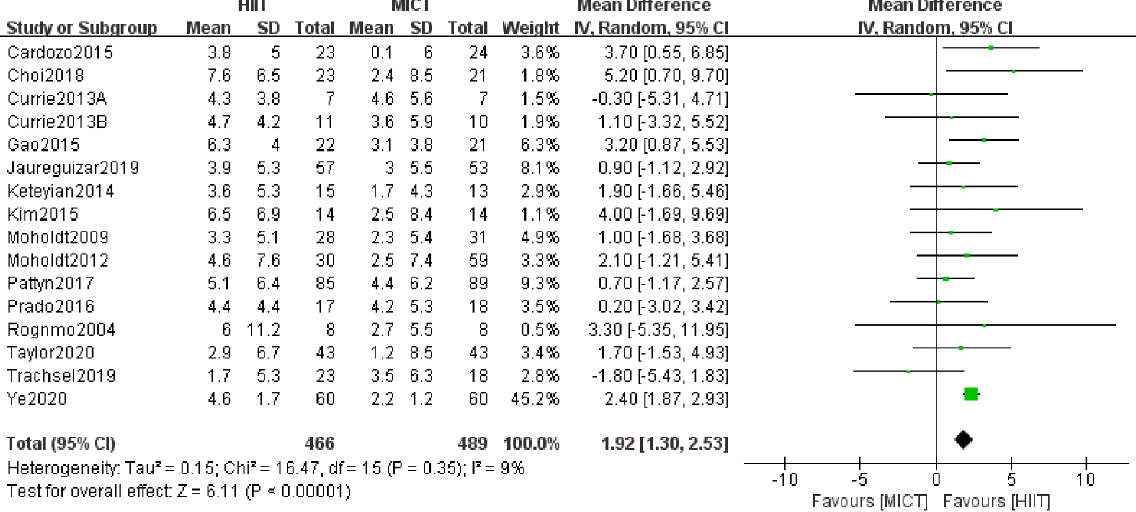
Figure 4. Changes in VO 2peak between HIIT and MICT. HIIT, high-intensity interval training; MICT, moderate-intensity interval training. The green and black symbol means the mean difference of each studies and total mean difference.